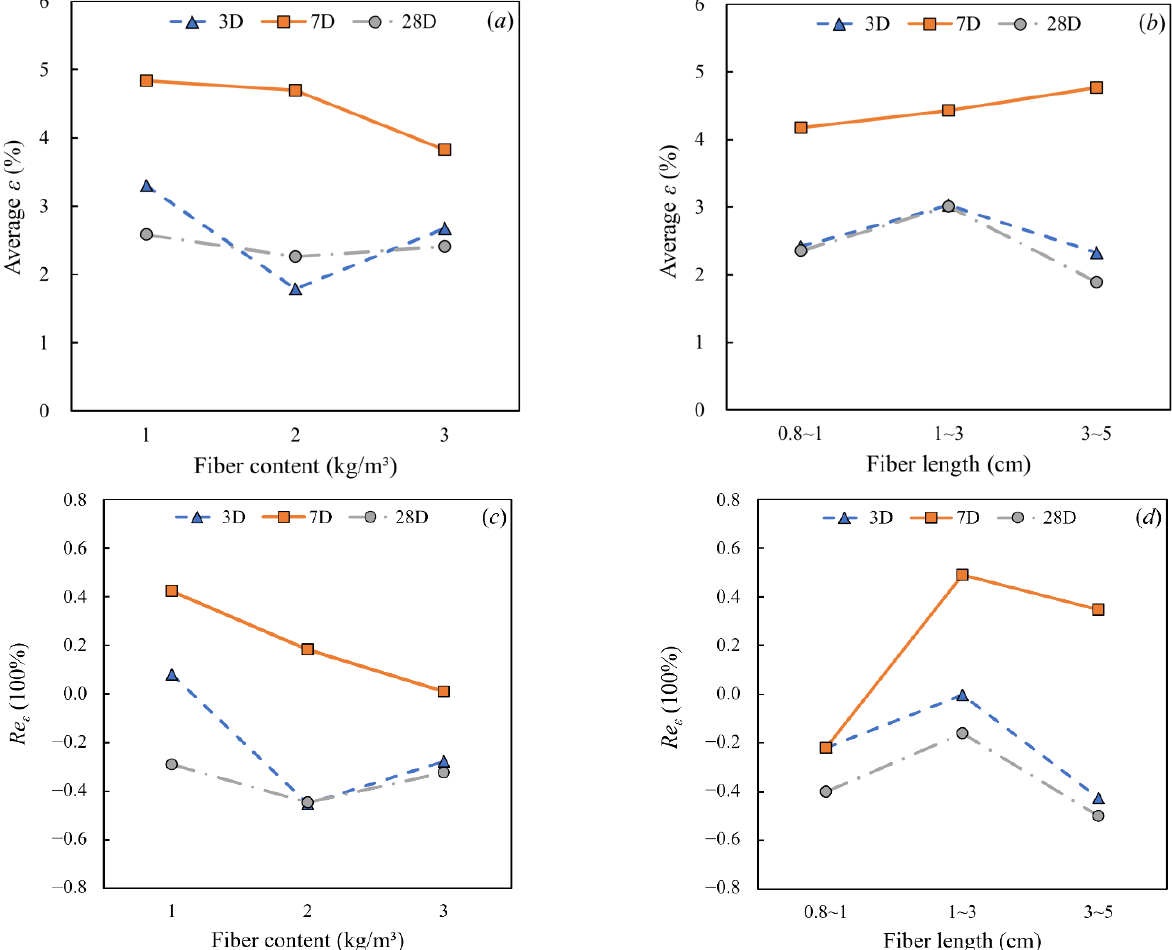
Figure 10. The influences of RS fiber on peak strain and Re ε . ( a ) Average ε at different RS fiber contents; ( b ) average ε at different RS fiber lengths; ( c ) average Re ε at different RS fiber contents; ( d ) average Re ε at different RS fiber lengths.